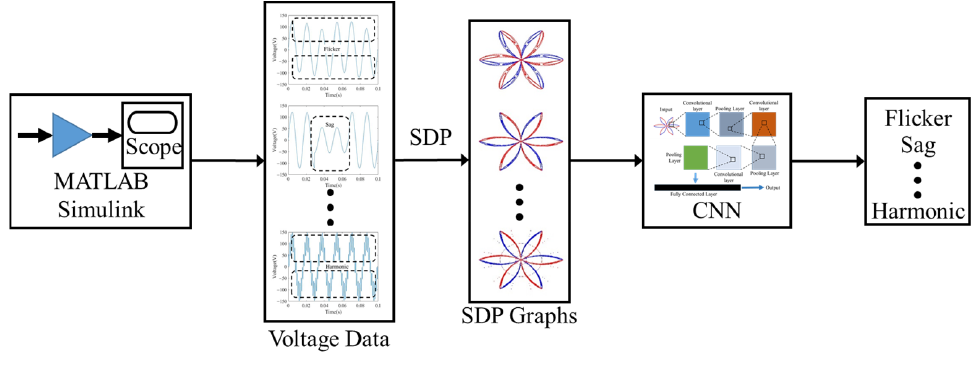
Figure 1. System